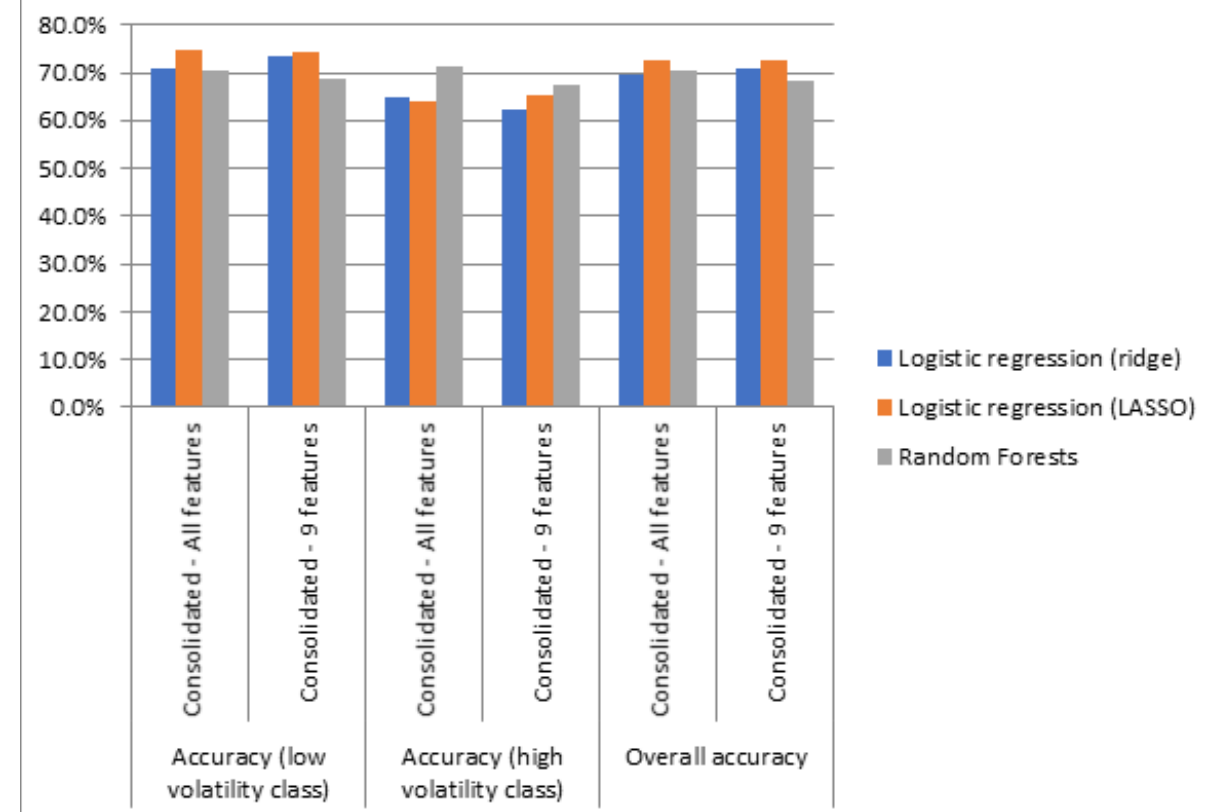
Figure 5. Comparison of consolidated prediction accuracy achieved by all 132 features versus the 9 selected important features. LASSO: least absolute shrinkage and selection operator.